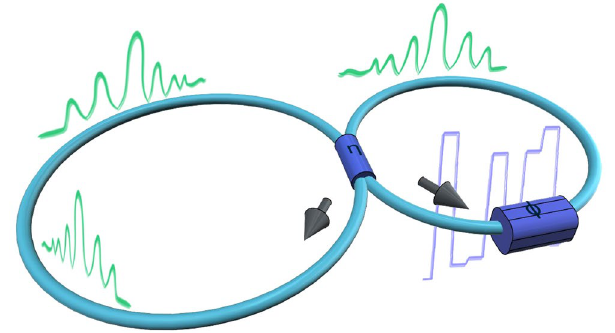
Figure 1. The scheme of the experimental realization of a synthetic mesh photonic lattice based on fiber loops with random